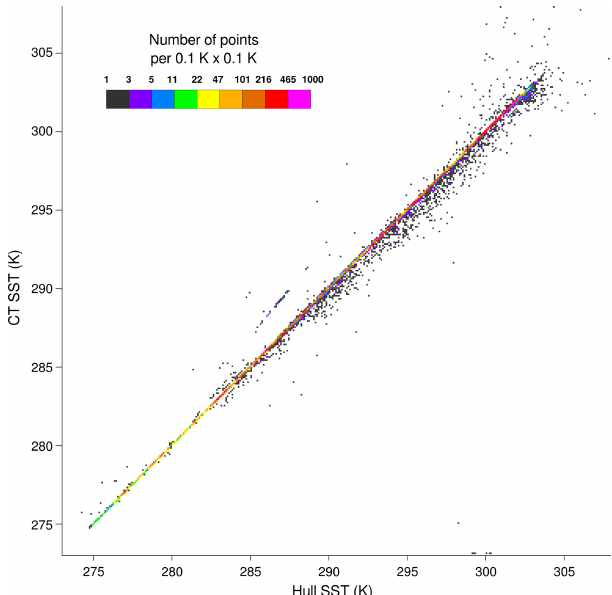
Figure 1. Density plot of the scatter between hull SST measure- ments (horizontal axis) and CT SST measurements (vertical axis) from HRSST-2 SVP-BS